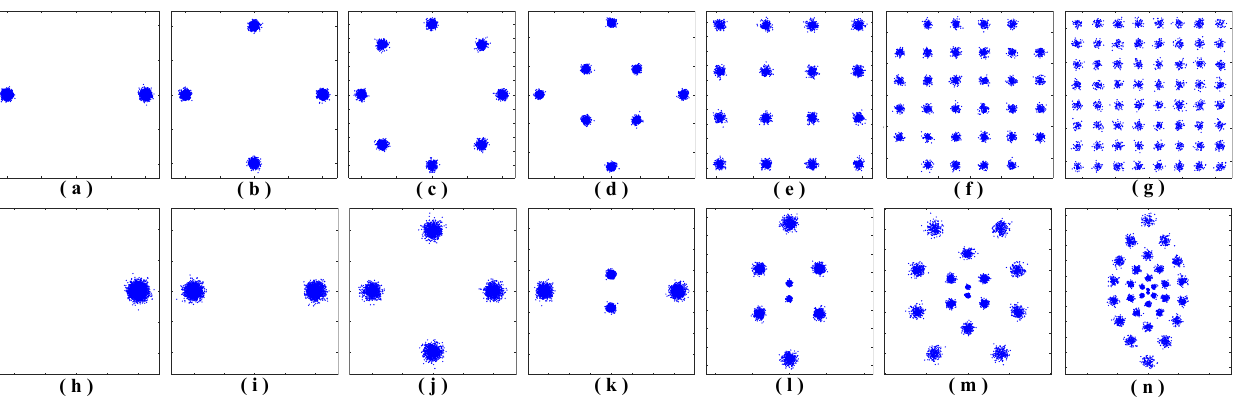
Figure 2. Constellation diagrams before and after the square operation of signals in modulation formats of BPSK, QPSK, 8PSK, 8QAM, 16QAM, 32QAM and 64QAM, respectively; ( a – g ) Constellation diagrams before the square operation of signals; ( h – n ) Constellation diagrams after the square operation of signals.